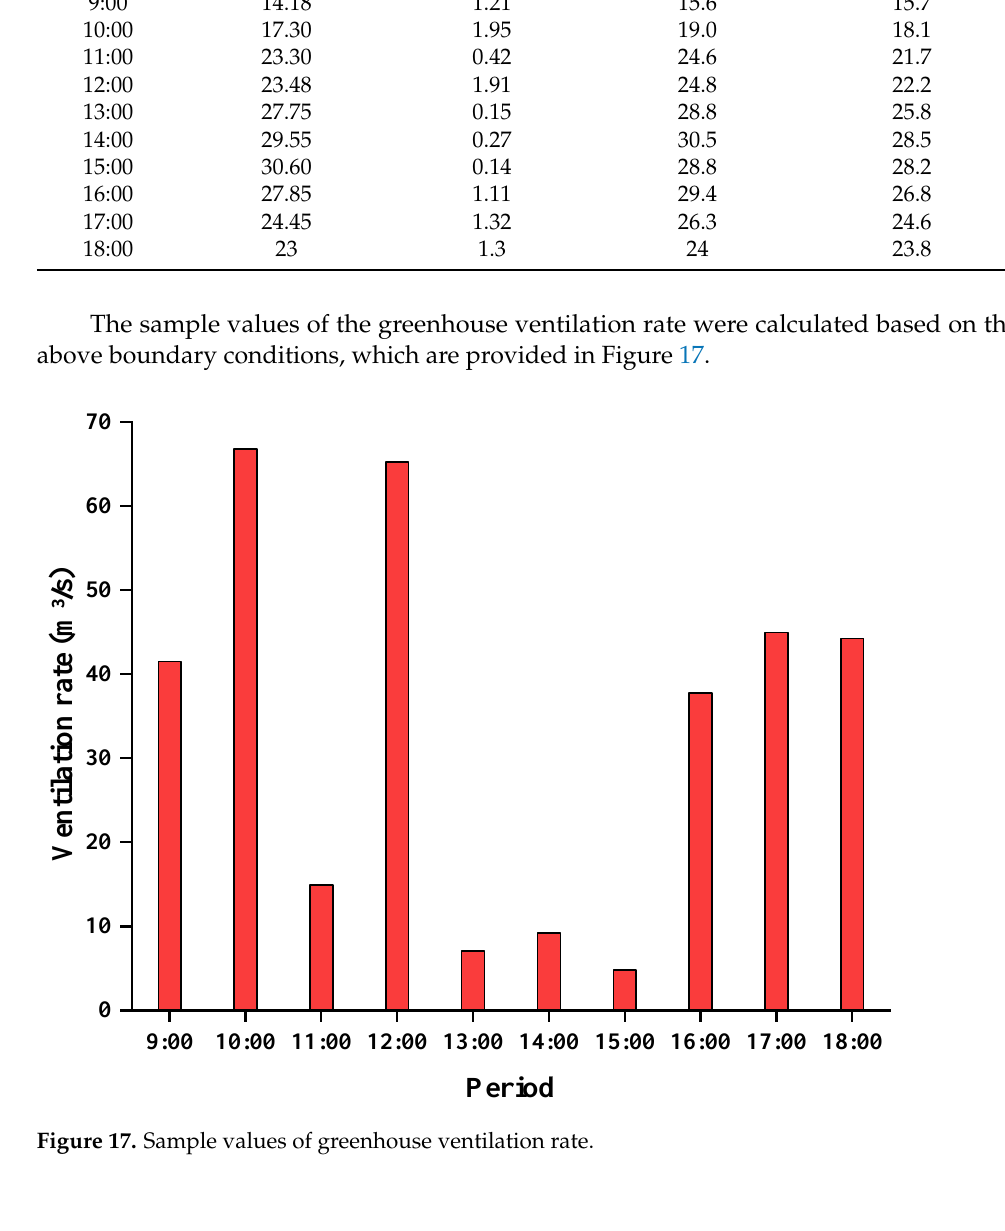
Table 5. Boundary conditions for ventilation calculation.